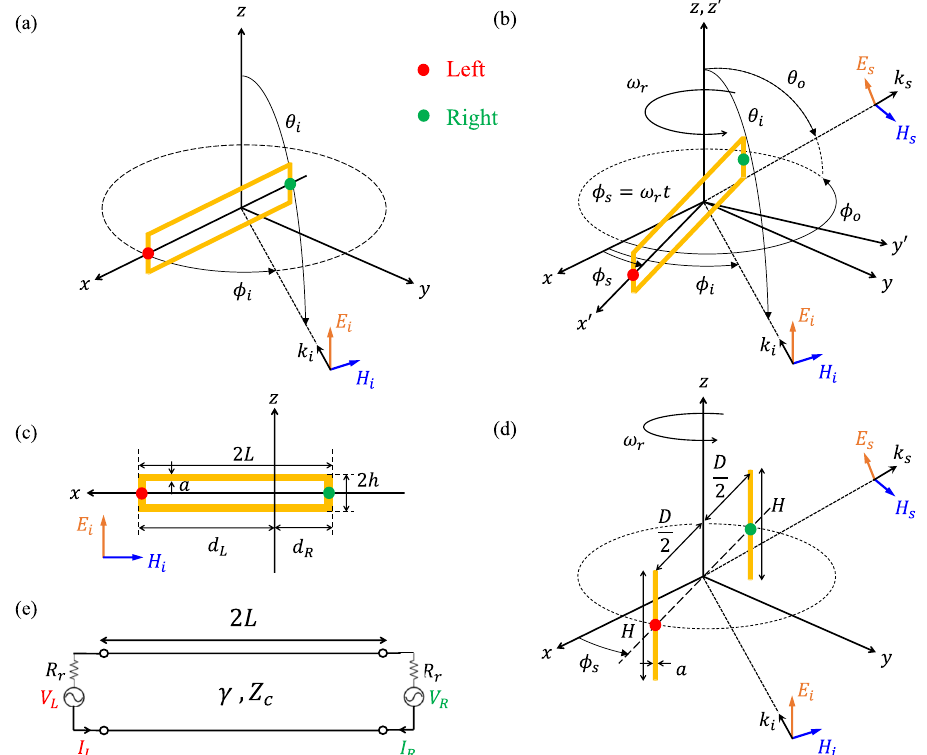
Figure 3. ( a ) Non-symmetrically positioned rectangular loop impinged by vertically polarized plane wave. ( b ) Scattering from non-symmetrically rotating rectangular loop. ( c ) Geometrical dimensions of the rectangular loop. ( d ) Scattering from two symmetrically rotating coupled dipoles. The left and right side radiating elements are respectively remarked with red and green dots. ( e ) The proposed circuit model for the wave-impinged